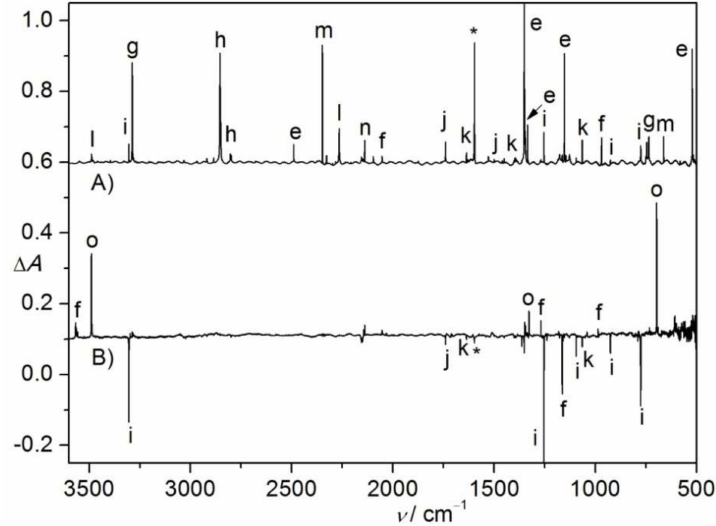
Figure 2. ( A ) IR spectrum (Absorbance, A ) of the N 2 -matrix isolated flash vacuum pyrolysis (600 K) products of CH 2 ClS(O) 2 N 3 . ( B ) IR difference spectrum (Absorbance, ∆ A ) showing the change of the N 2 -matrix upon subsequent 266 nm laser photolysis (25 min). For clarity, spectrum B is 12-fold expanded along the ∆ A axis. The IR bands of SO 2 (e), unknown species (f), HCN (g), HCl (h), HNSO (i), H 2 CO (j), CH 2 NH (k), HNCO (l), CO 2 (m), CO (n), HOSN (o), and impurity H 2 O (*) are labeled. For clarity, the spectra are arbitrarily shifted along the ∆ A